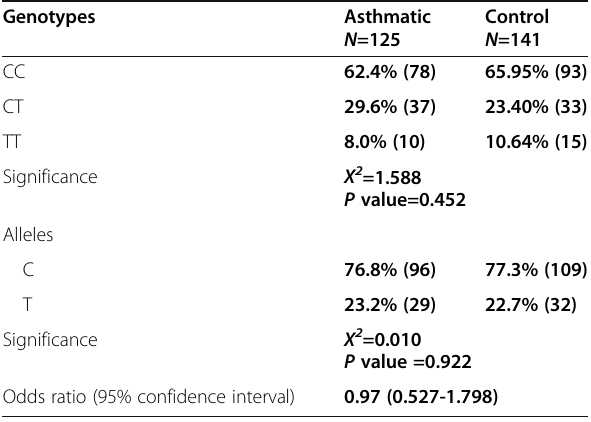
Table 2 The distribution of rs3744246 ( ORMDL3 gene) polymorphism genotype and allele frequencies in the Algerian population studied